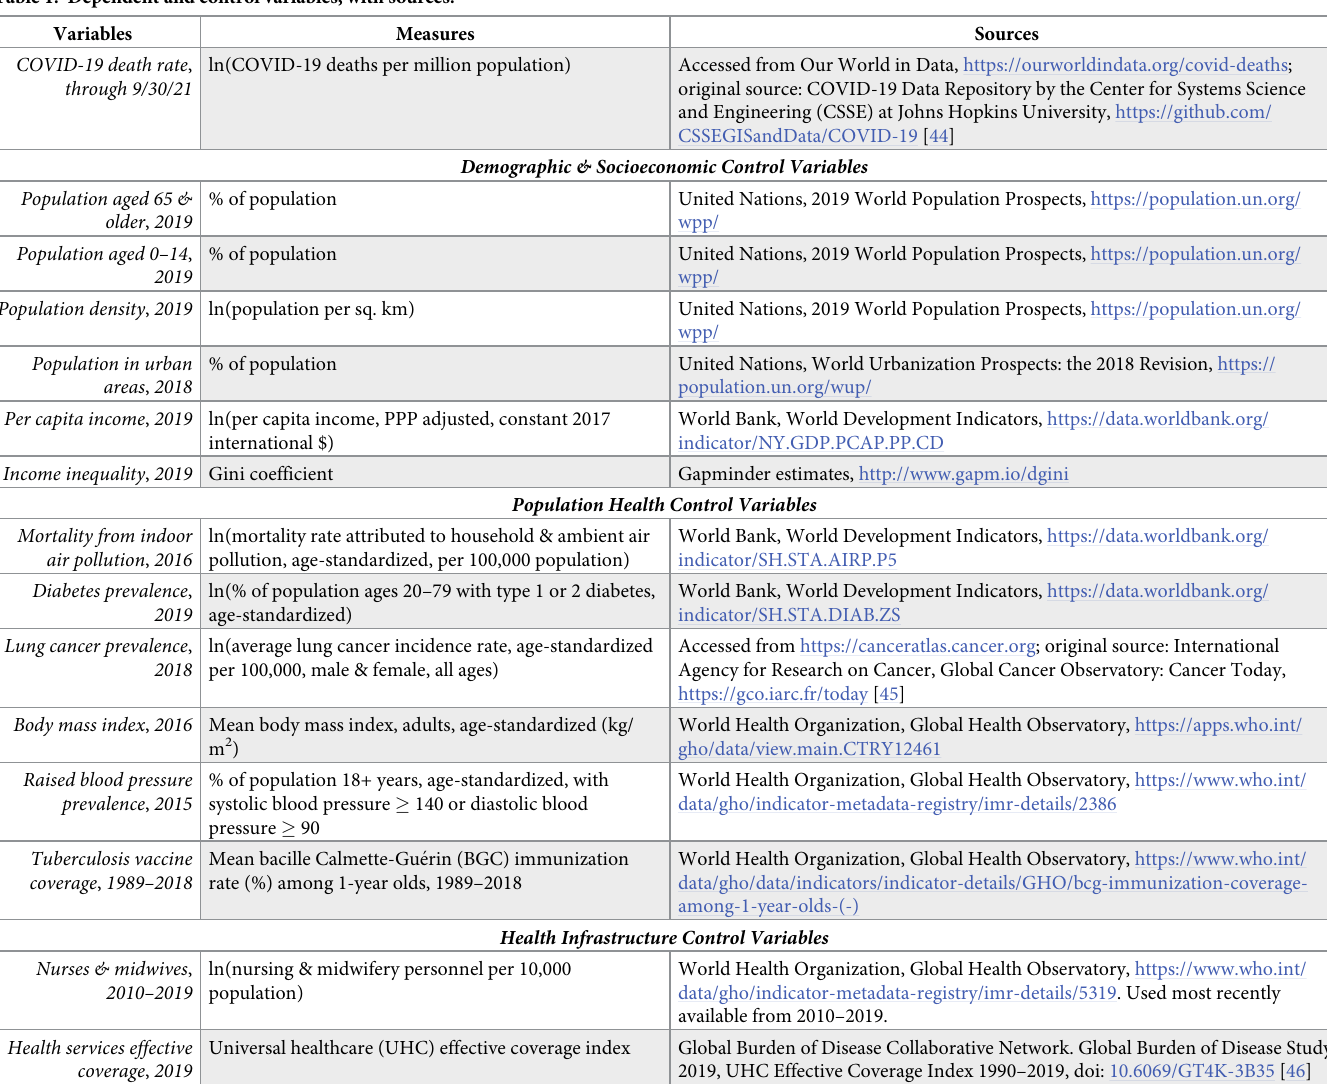
Table 1. Dependent and control variables, with